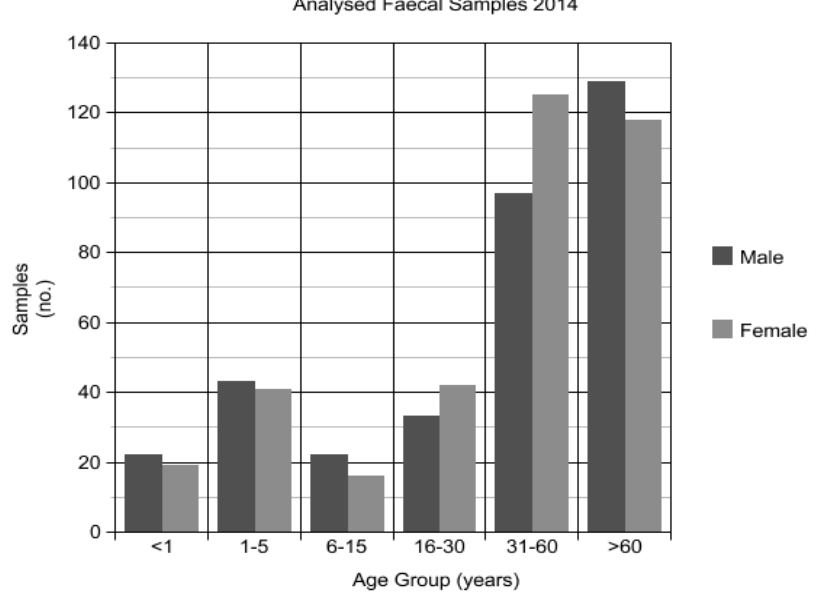
Figure 4. Demographics of patient faecal samples received at Townsville Hospital Microbiology Laboratory (TTHML) in 2014 and assessed by Strongyloides sp. qPCR.